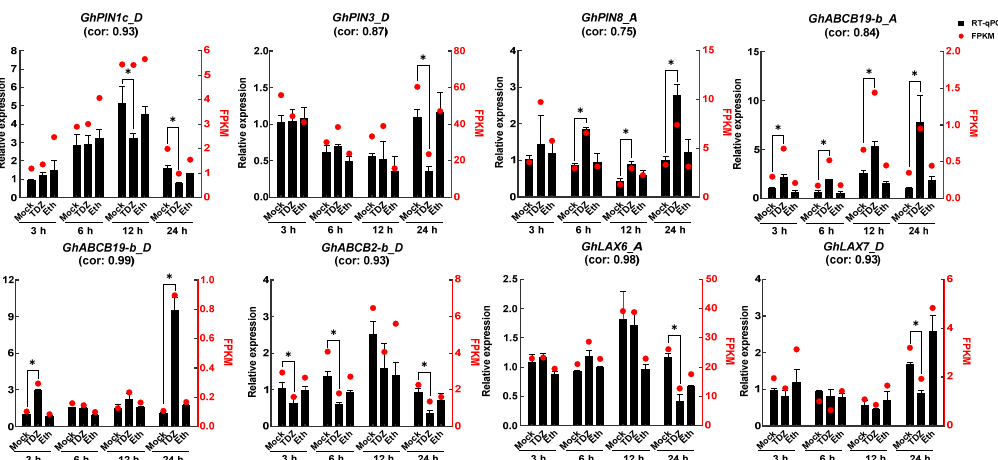
Figure 8. Expression profiles of genes with specific response to 300 mg/L thidiazuron (TDZ) com- pared with 0.6 mg/L ethephon (TDZ-SRGs) related to auxin transport. Pearson’s correlation coeffi- cient was used to estimate the agreement (cor) between the RT-qPCR expression levels and RNA-seq data. Red dots indicate FPKM value from RNA-seq. Significant differences between TDZ or Eth and Mock were determined by t -test, * indicates p -value < 0.05.